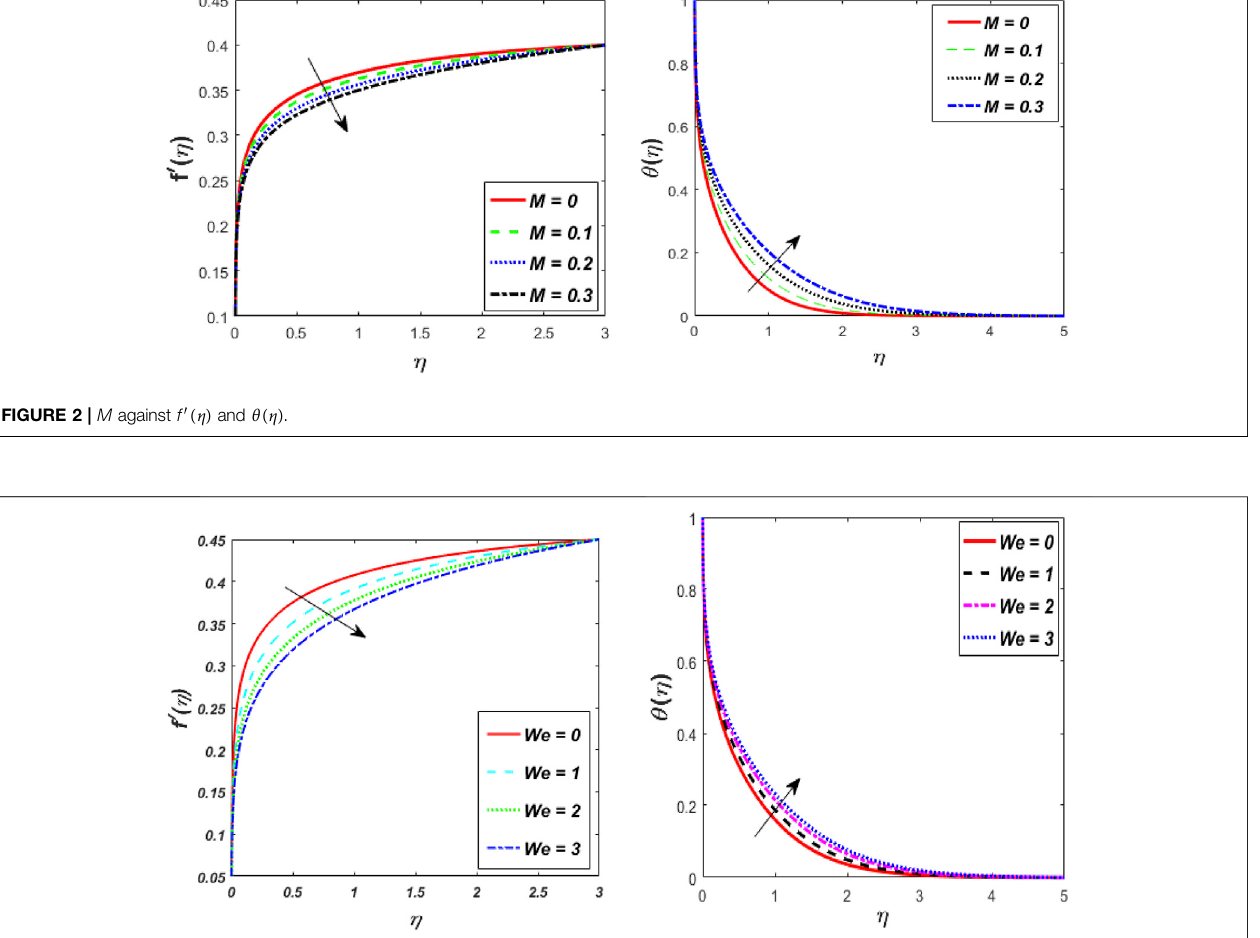
FIGURE 3 | We against f ′ ( η ) and θ ( η ) .